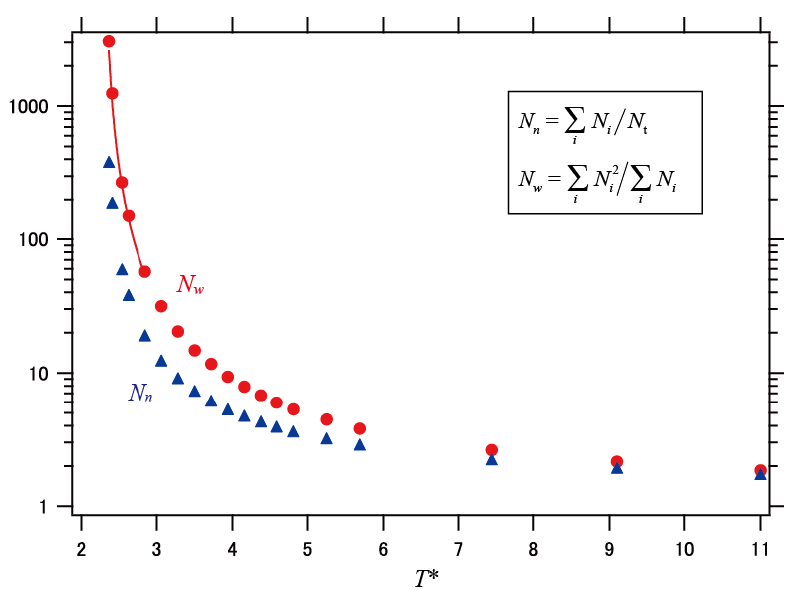
Figure 2. Temperature dependence of the average of the number of segments per DCN. N w is the weighted average, N n is the number average, and T* is the reduced temperature defined as T* = kT/ε . The solid curve indicates the fitting result based on Equation (5).